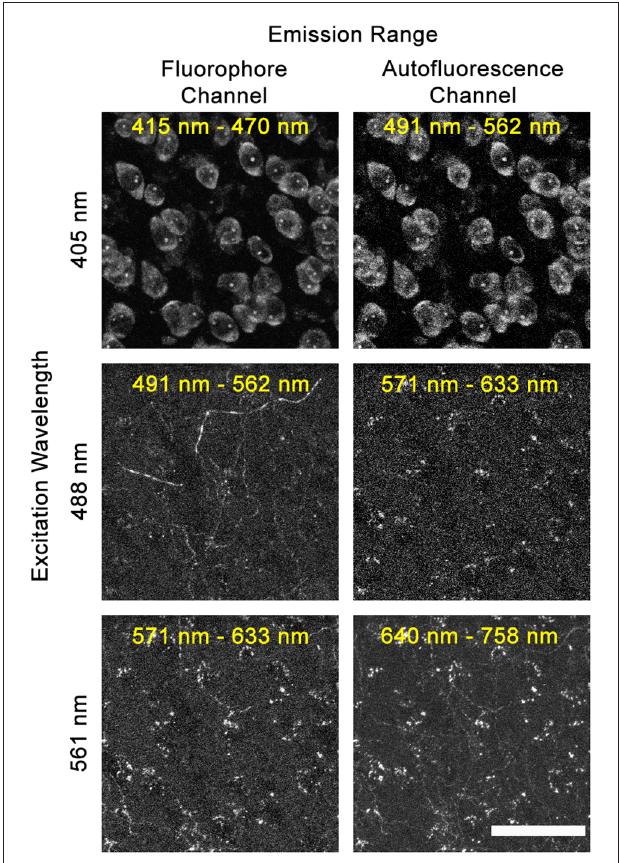
FIGURE 2 | Selecting the optimal autofluorescence channel. Images show fluorescent emission at selected wavelengths after excitation using 405 nm, 488 nm, or 561 nm lasers. In our experiments using blue, green, red, and far-red fluorophores, the optimum autofluorescence channel was created by exciting the tissue with a 488 nm laser and imaging fluorescence between 571 nm and 633 nm. When exciting with the 405 nm laser, the broad emission spectrum of the blue NeuroTrace Nissl overlaps the autofluorescence channel. When exciting with the 561 nm laser, the broad excitation range of far-red Alexa Fluor 633 leads to labeled fibers being captured in the 640–758 nm autofluorescence channel. Scale bar: 50 µ m.